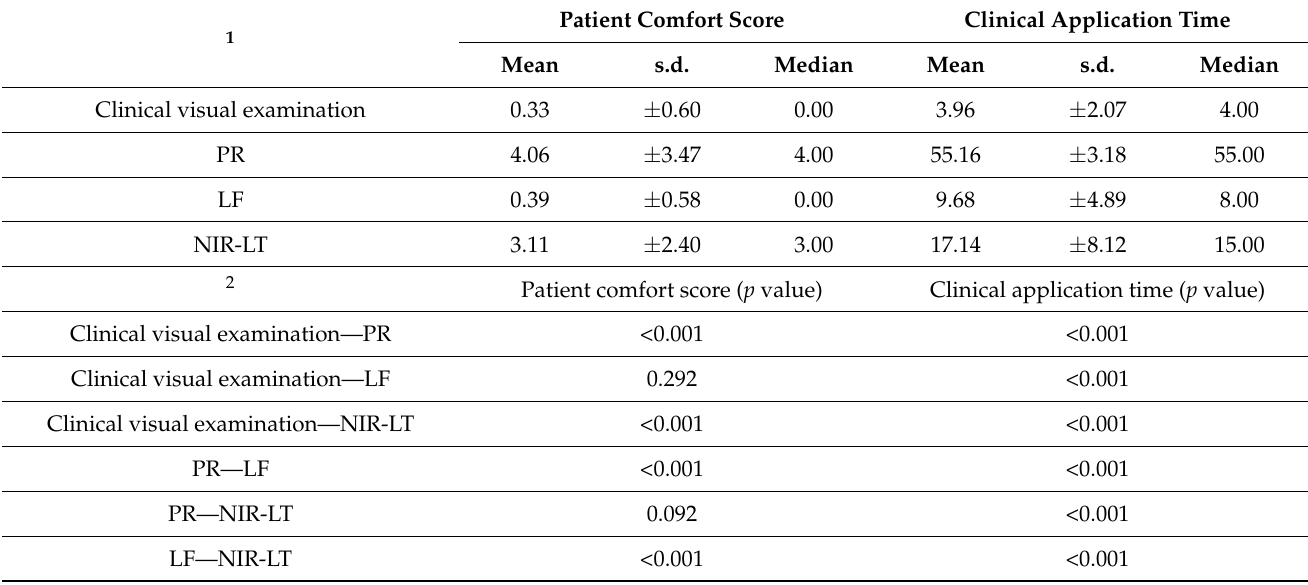
Table 4. Comparison of patient comfort score and clinical application time in seconds for each diagnostic test as mean, median, standard deviation. (s.d), p